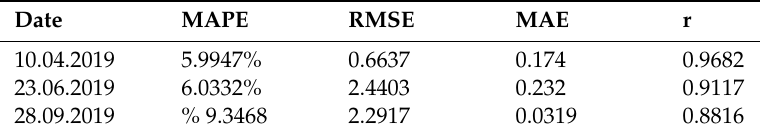
Table 9. Statistical performance measures for temperature.